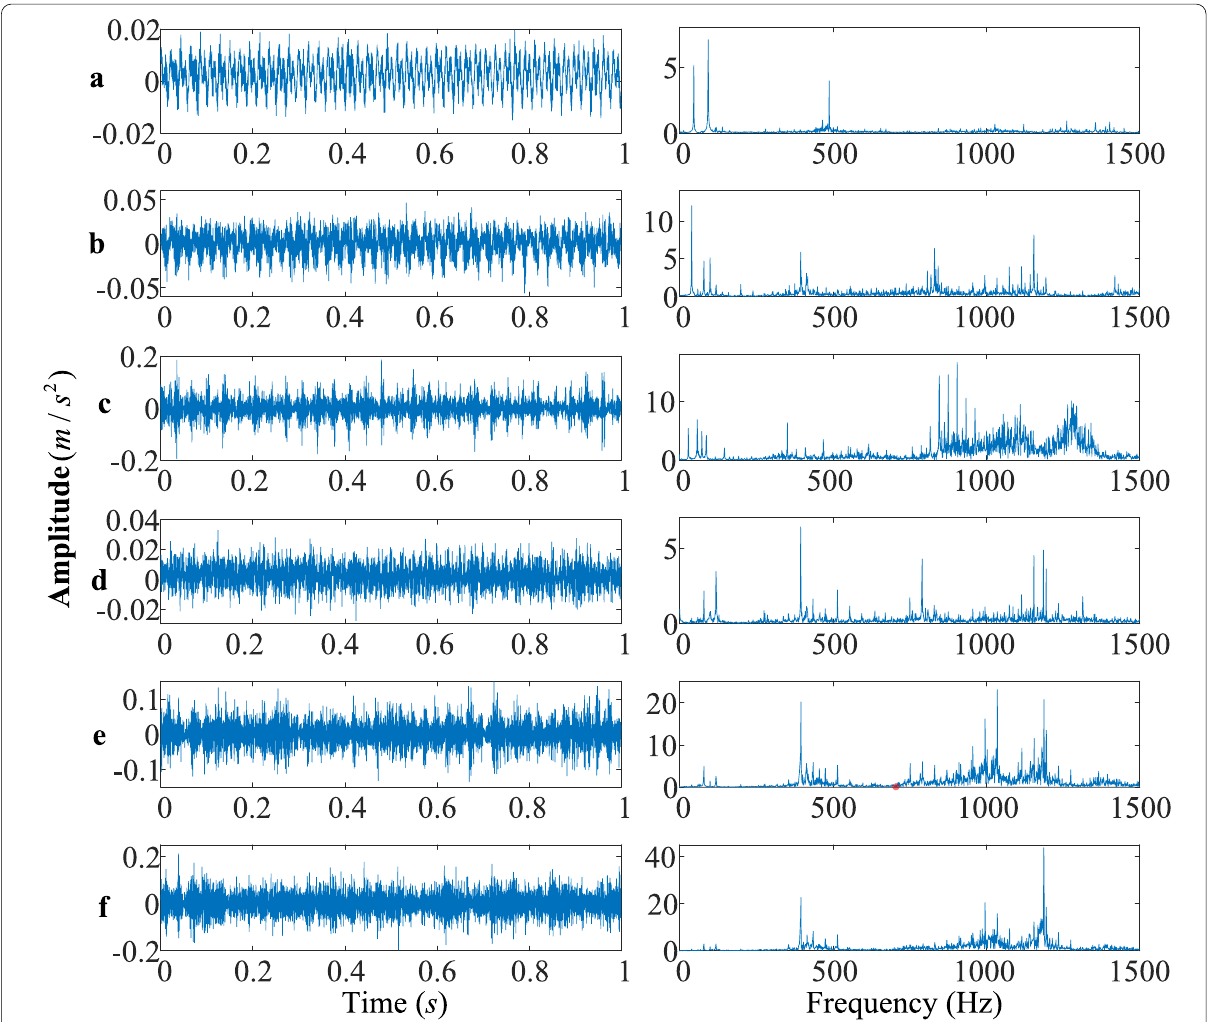
Figure 8 Vibration signals of gearbox under six working conditions: a normal, b gear hub crack, c gear broken teeth, d compound faults 1, e compound faults 2, f compound faults